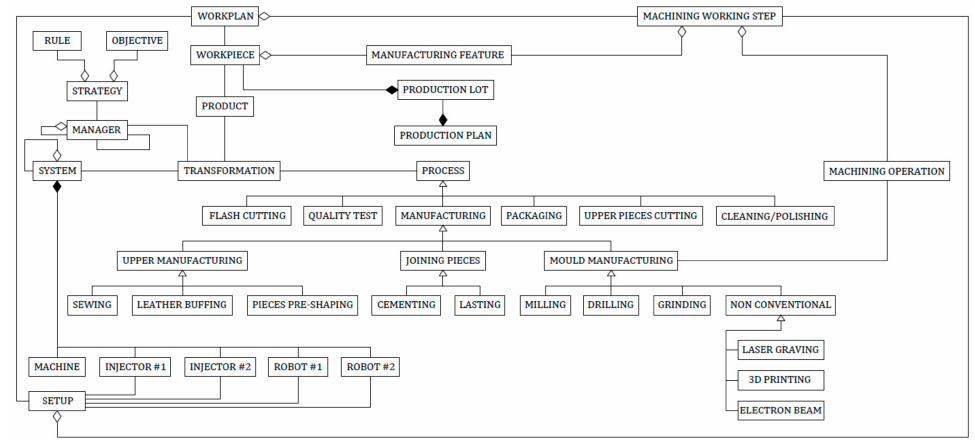
Figure 3. Class diagram of the conceptual reference